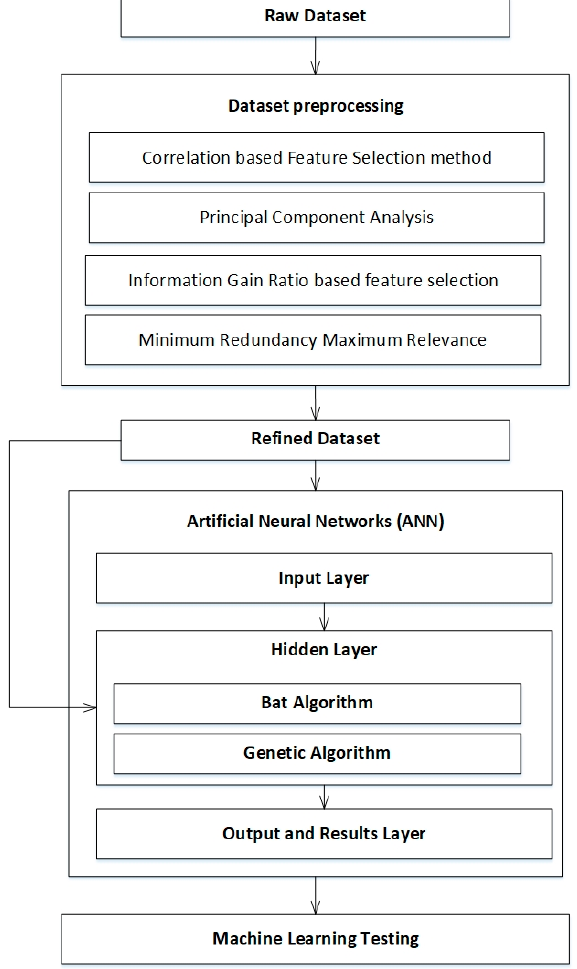
Figure 1. General framework of the proposed method.